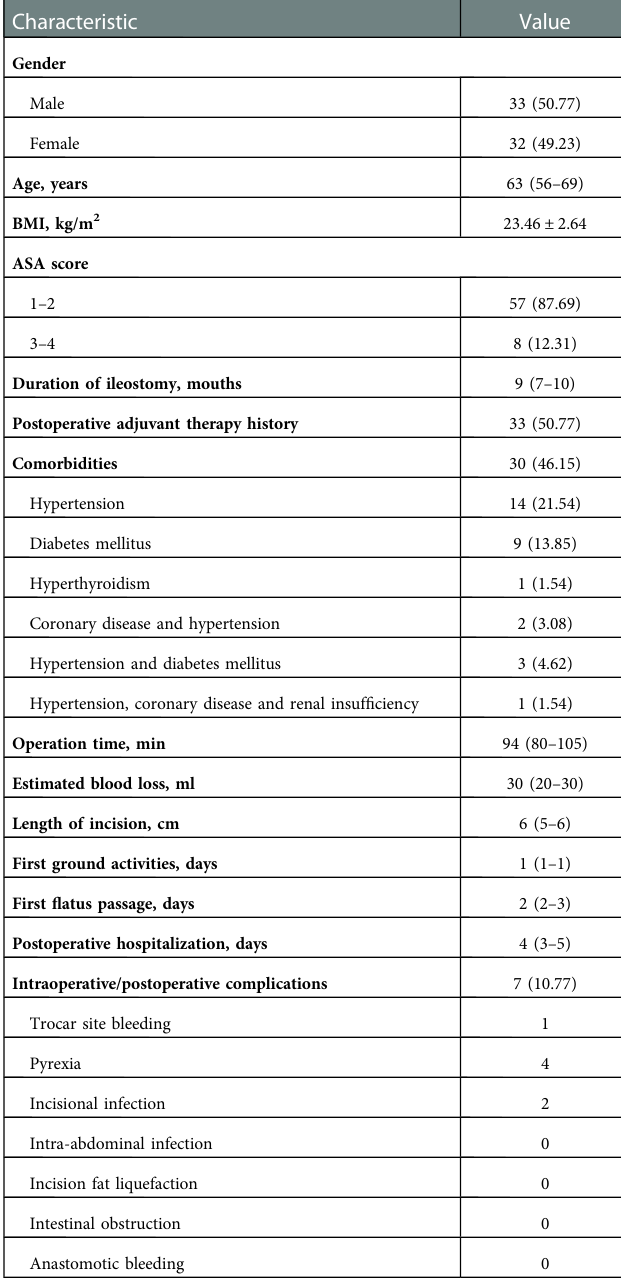
postoperative complications (trocar site bleeding, n = 1; pyrexia, TABLE 1 Patient demographics and clinical pro fi